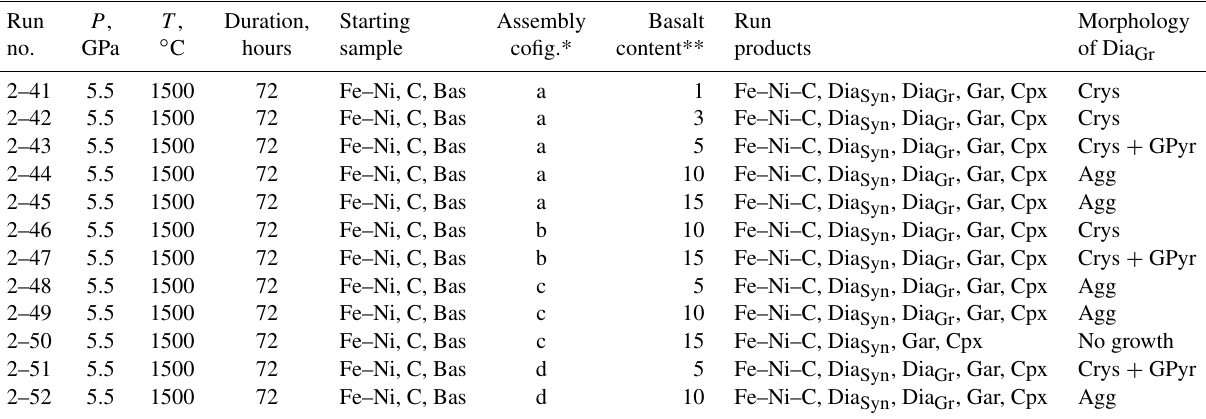
Table 1. Experimental conditions and run products. Run P , T , Duration, Starting Assembly Basalt Run Morphology no. GPa ◦ C hours sample cofig.*